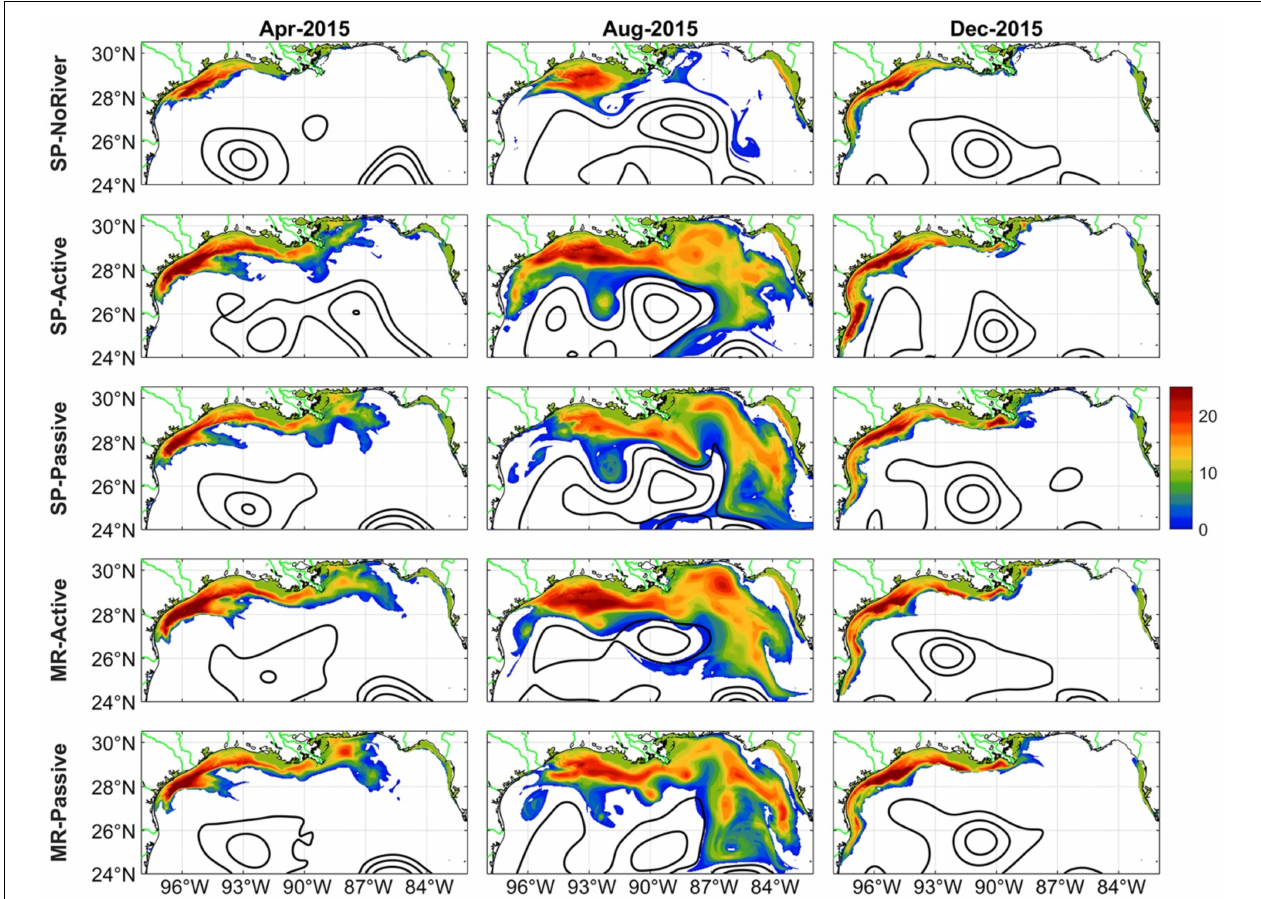
FIGURE 4 | Monthly and vertically averaged freshwater (=34 psu) extension in Apr, Aug, and Dec 2015 with different model setup. Color shading denotes the thickness of the freshwater patches in meters. SSHa contours (0.17, 0.4, and 0.6 m) are also